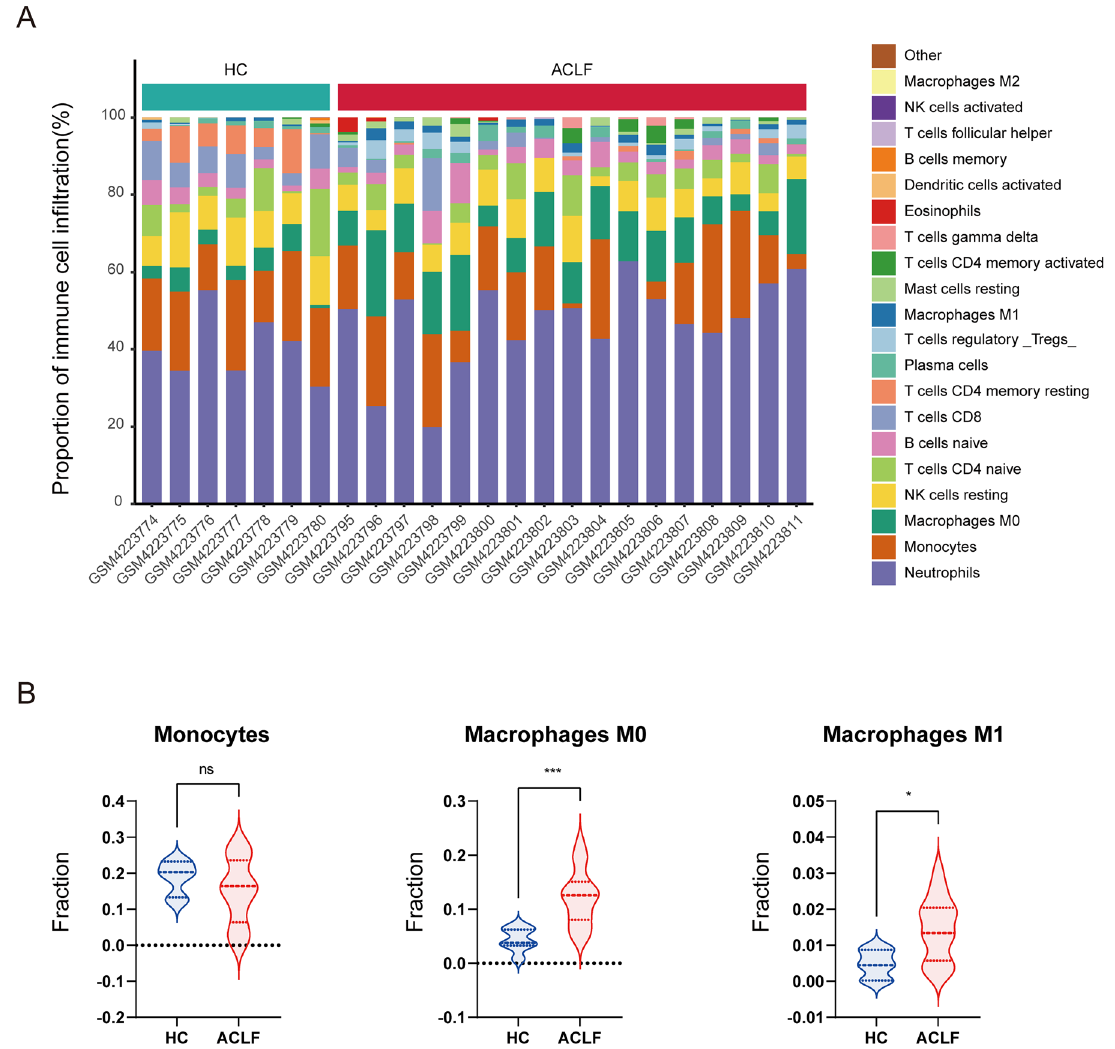
Figure 7. Immune cell composition in ACLF. ( A ) Proportions of 22 immune cells in ACLF patients and HS. ( B ) Differences in the proportion of M0 and M1 macrophages, and monocytes between ACLF patients and